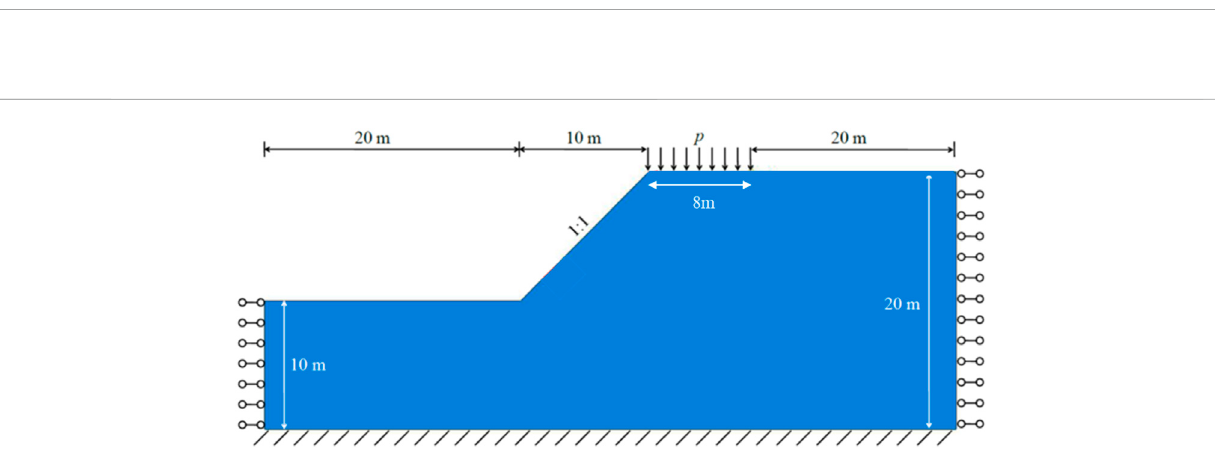
FIGURE 10 The model of the simulated soil-rock mixture